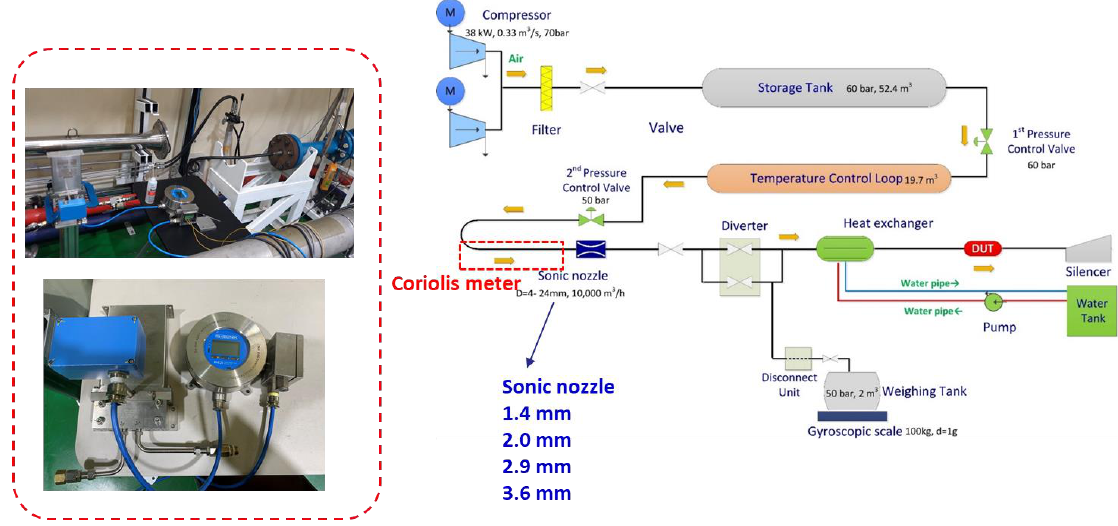
Figure 4. Installation of the Coriolis mass flowmeter for the density-matching experiments.